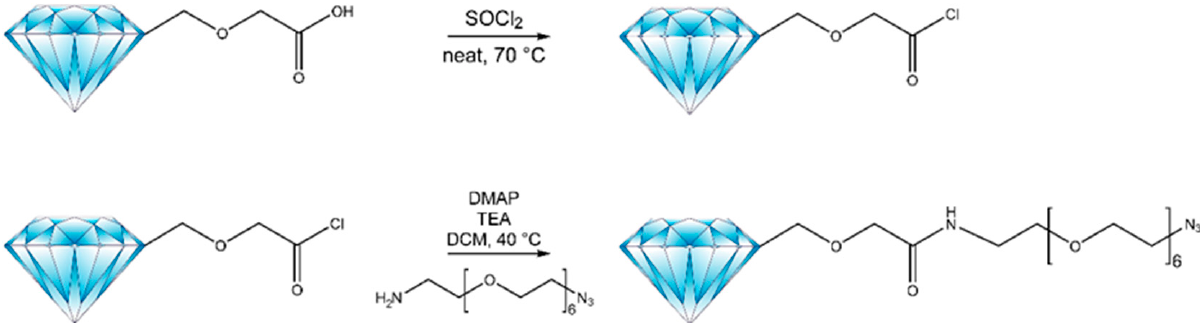
Figure 1. FTIR spectra of detonation nanodiamonds through the carboxylic acid enrichment proce- dure. The spectra correspond to untreated nanodiamonds (red line), nanodiamonds reduced with LiAlH 4 (blue line), and LAH reduced nanodiamonds following carbenoid insertion and subsequent ester cleavage (green line). The pink area highlights the C=O stretch at ~1750 cm − 1 , whereas the blue area highlights the C-O stretch associated with the ether bond at ~1200 cm − 1 .